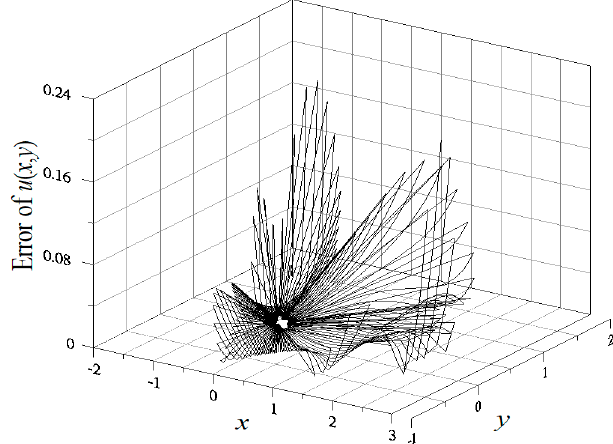
Figure 21. Numerical errors with random noise.